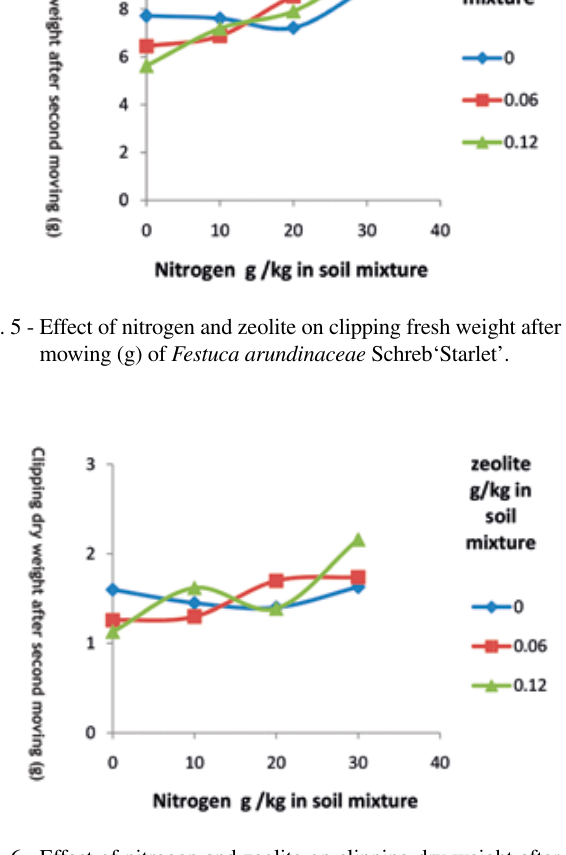
Fig. 6 - Effect of nitrogen and zeolite on clipping dry weight after third mowing (g) of Festuca arundinaceae